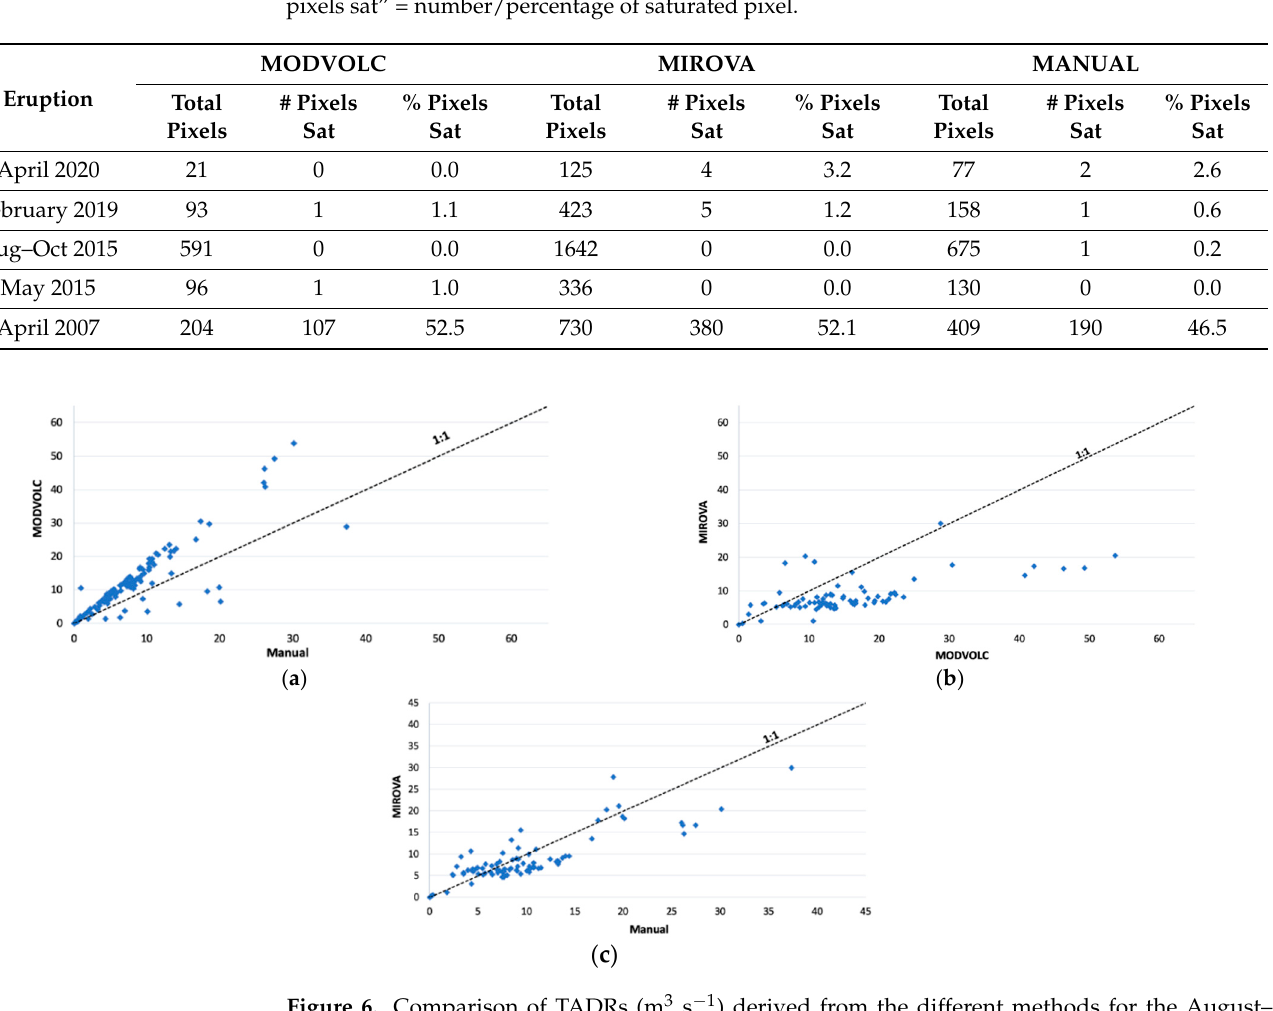
Figure 6. Comparison of TADRs (m 3 s − 1 ) derived from the different methods for the August–October 2015 eruption: ( a ) MODVOLC versus Manual; ( b ) MIROVA versus MODVOLC; ( c ) MIROVA versus Manual.